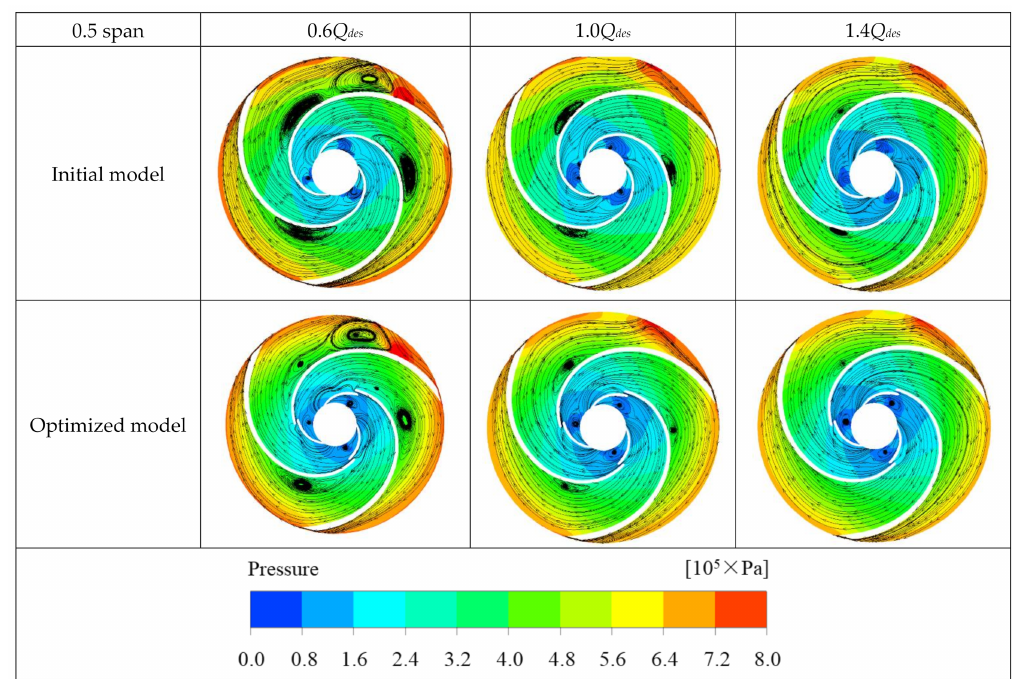
Figure 10. Distribution of static pressure and streamline within initial and optimized